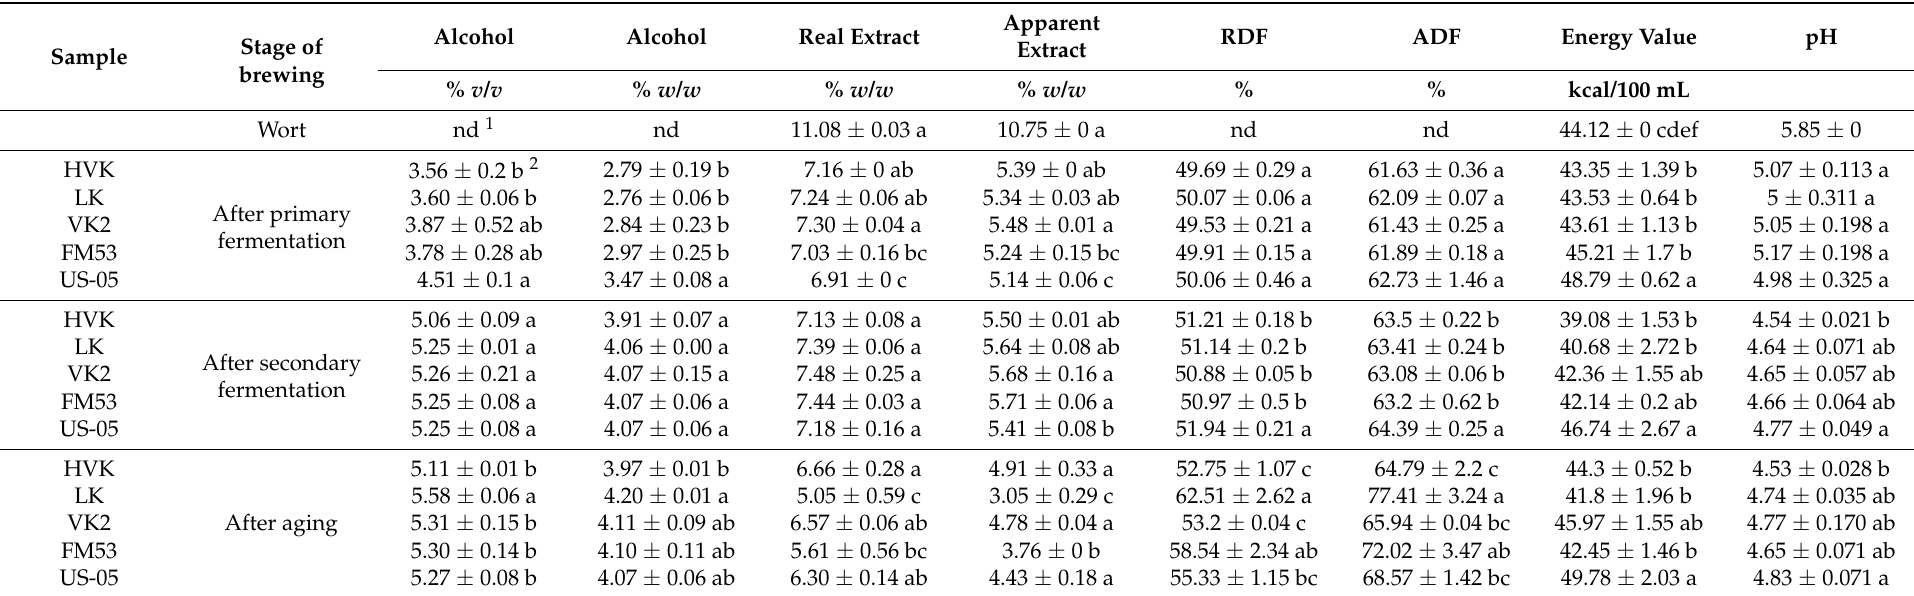
Table 1. Basic physicochemical